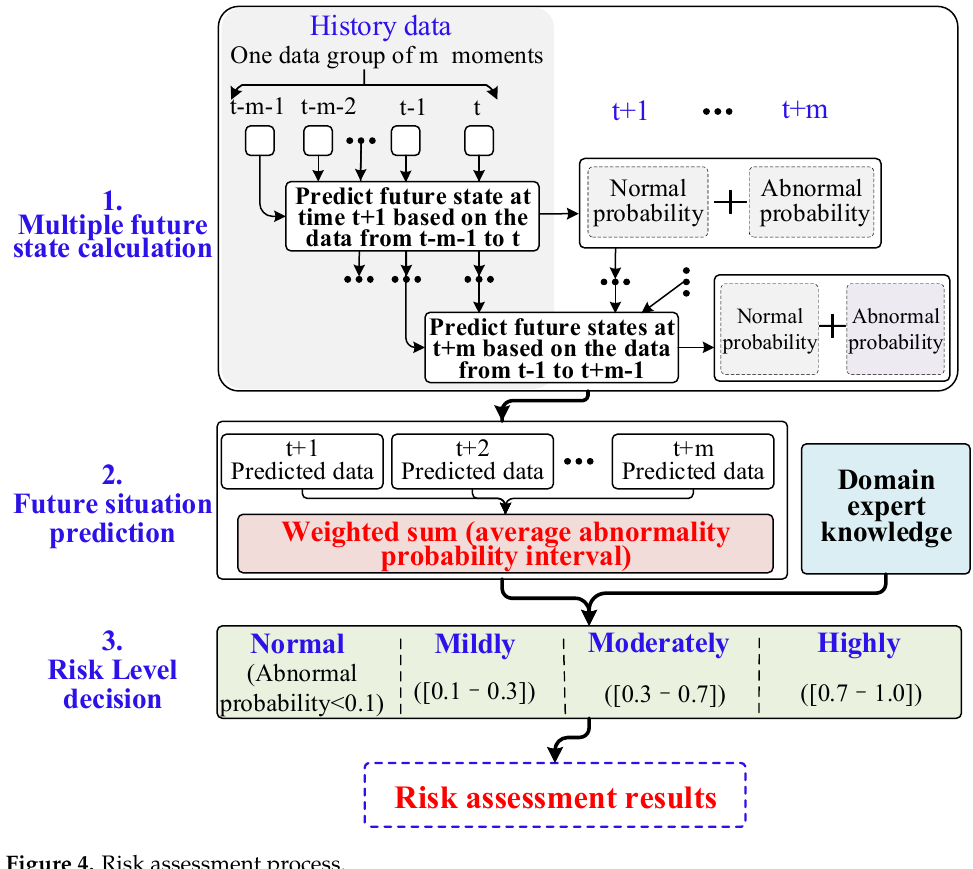
Figure 4. Risk assessment process.